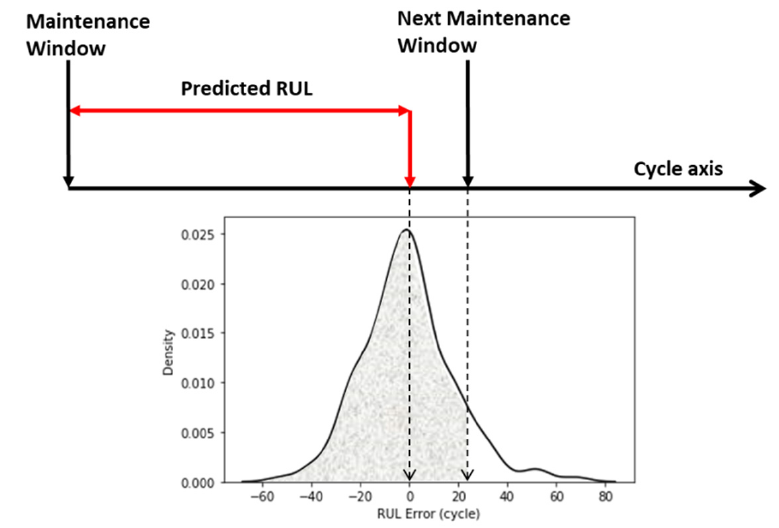
Figure 16. The RUL error distribution and confidence interval for maintenance.